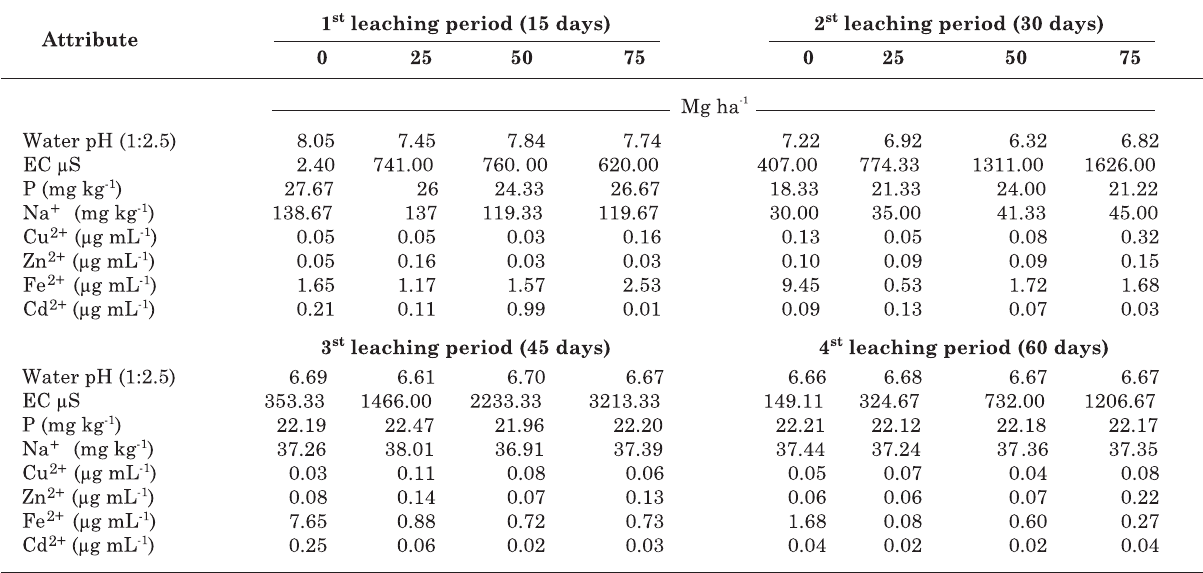
Table 4. Average results obtained by chemical analysis of the effluents collected 15, 30, 45, and 60 days after